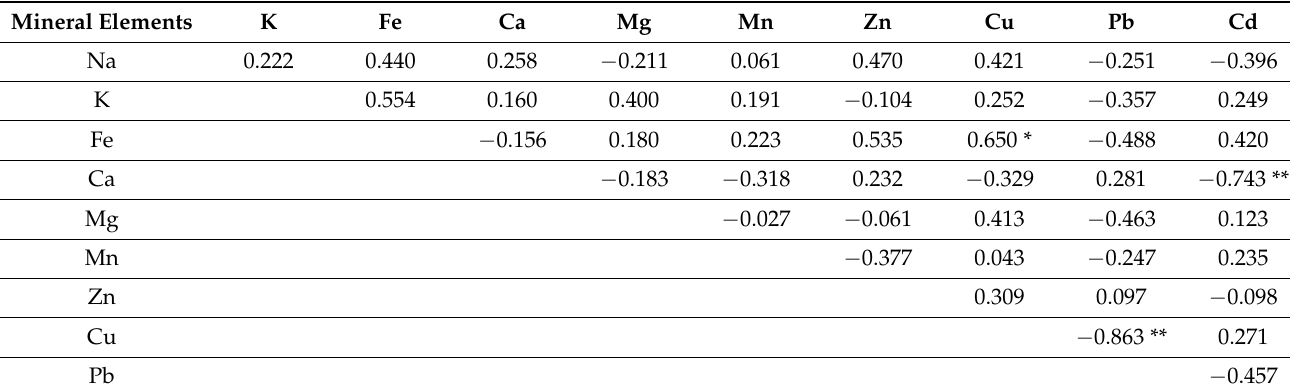
Table 6. Correlation coefficients (r xy ) for the levels of selected mineral elements and toxic metals in the testicles of red deer. Mineral